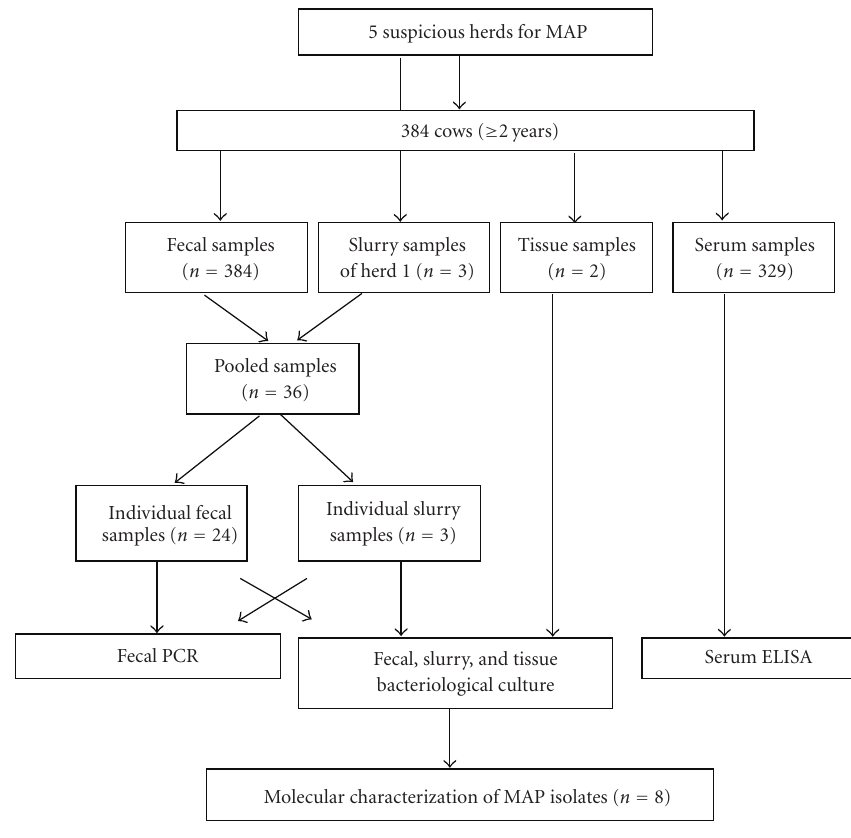
Figure 1: Overview of the study